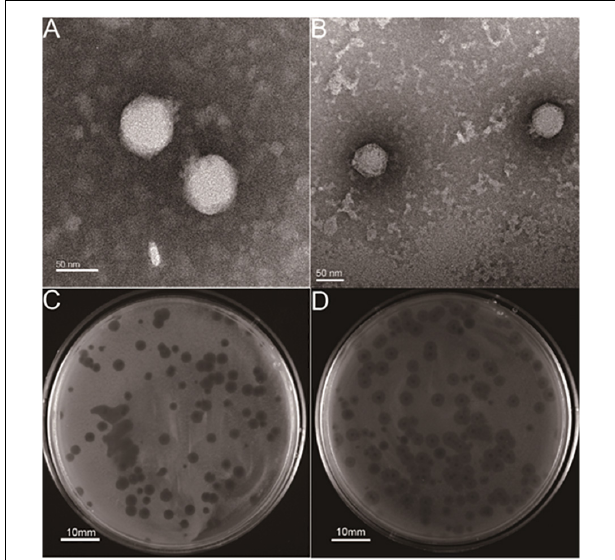
FIGURE 1 | Structural characterization and plaque morphology of isolated phages. TEM of phage (A) hvKpP1 and (B) hvKpP2. The bar indicates 50 nm. Plaques of phage (C) hvKpP1 and (D) hvKpP2 on K. pneumoniae hvKpLS7. The bar indicates 10 mm.